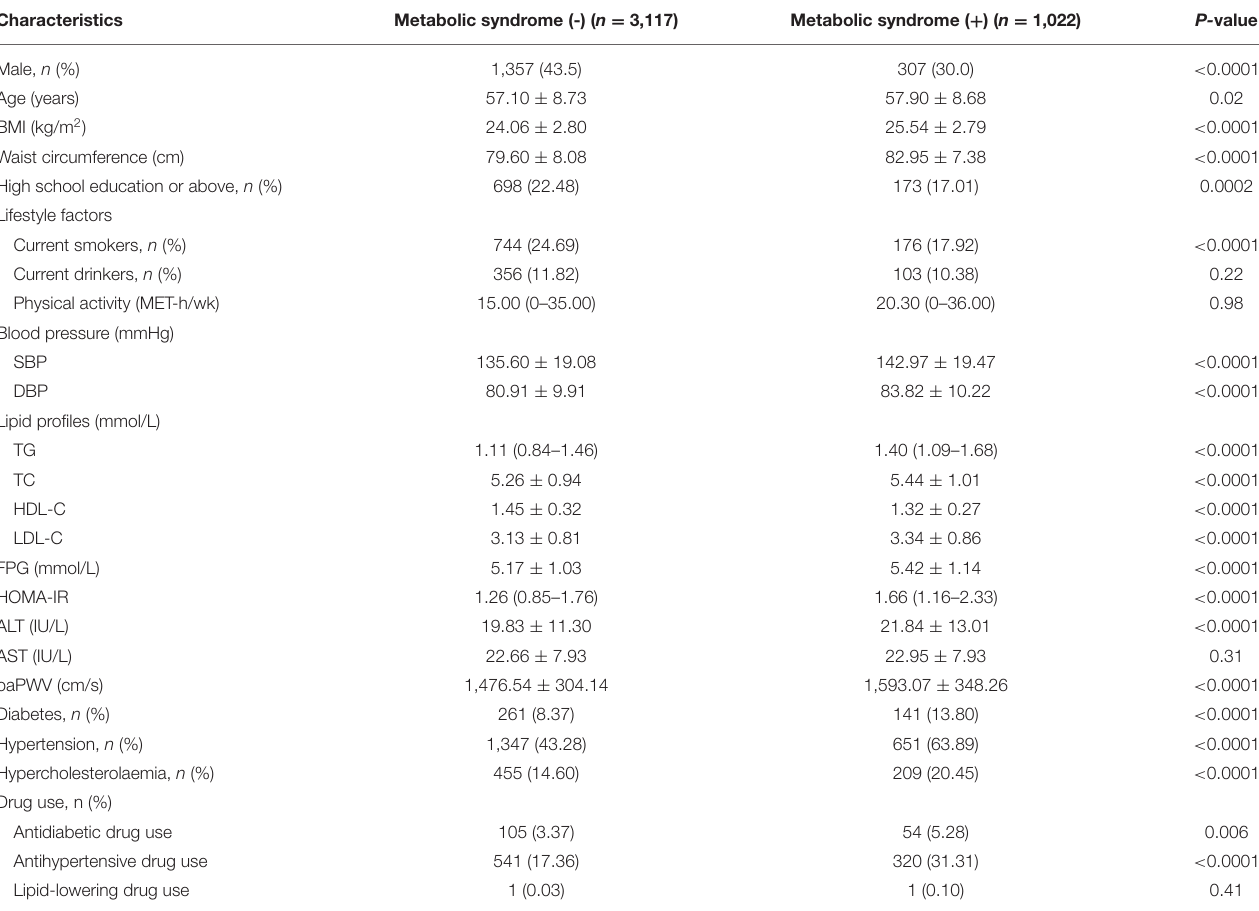
TABLE 1 | Baseline characteristics of participants according to incident metabolic syndrome ( n = 4,139).